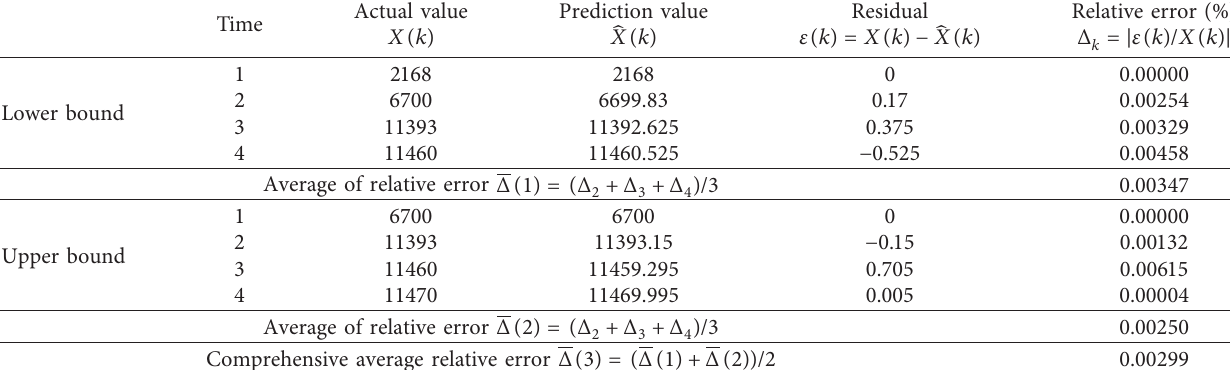
Table 3: Upper and lower bound errors.